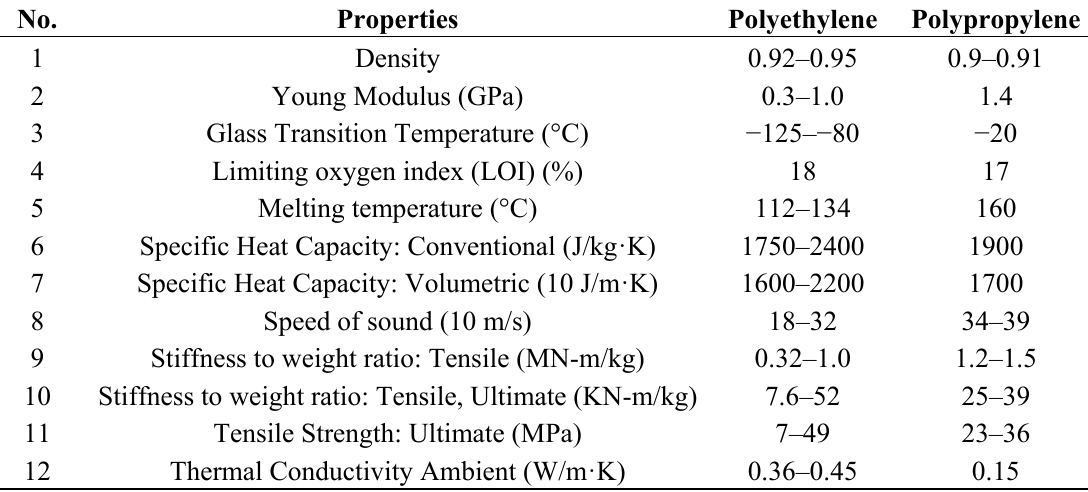
Table 1. Physical properties of polyethylene (PE) and polypropylene (PP), reprinted with permission from [3]. Copyright 2013 World